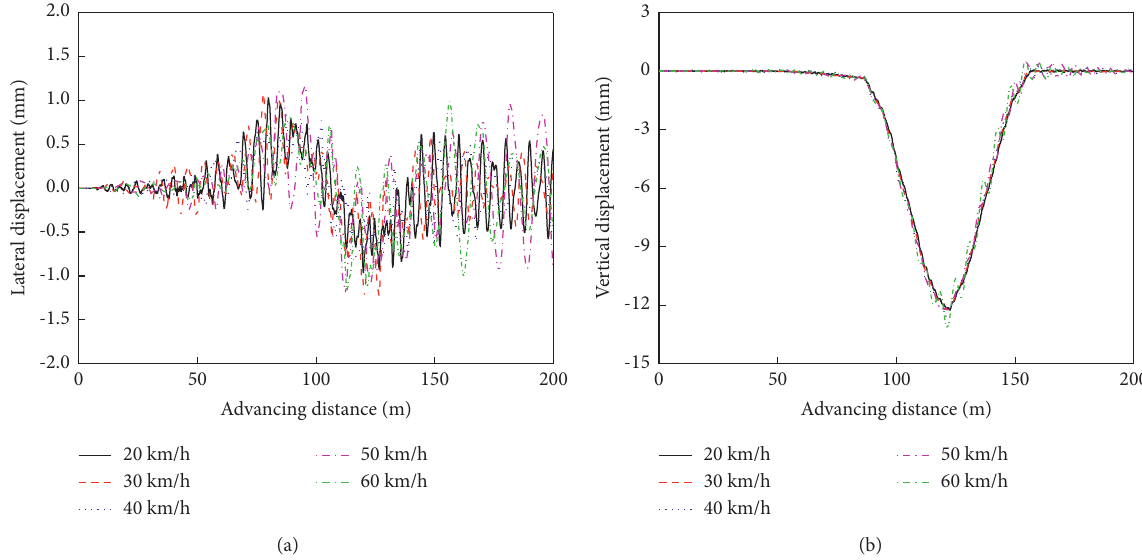
Figure 9: Comparison on time history of midspan displacements of landscape footpath at different vehicle speeds. (a) Lateral. (b)